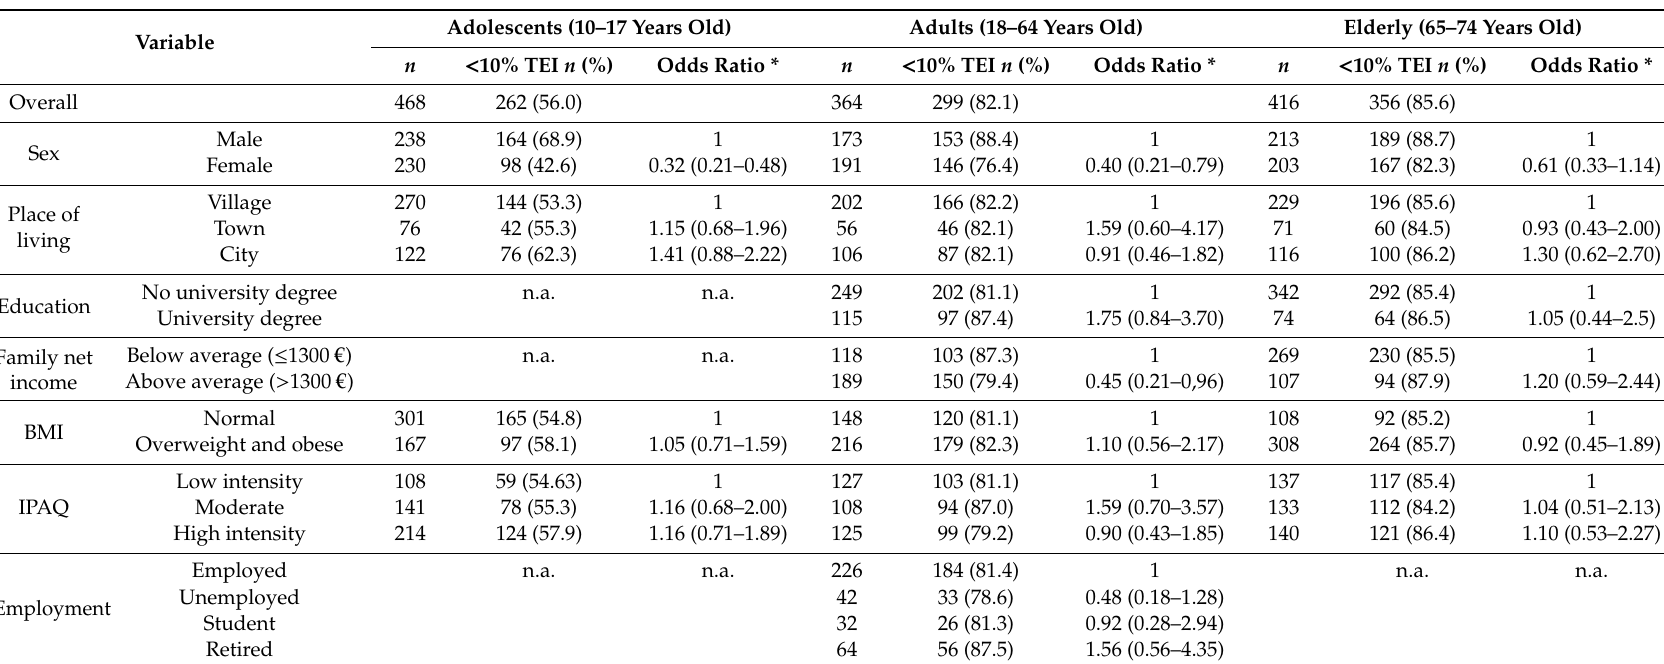
Table 5. Percentage of the population meeting recommendations for free sugars intake ( < 10% total energy intake) by sex, place of living, education, family net income, BMI, IPAQ, and